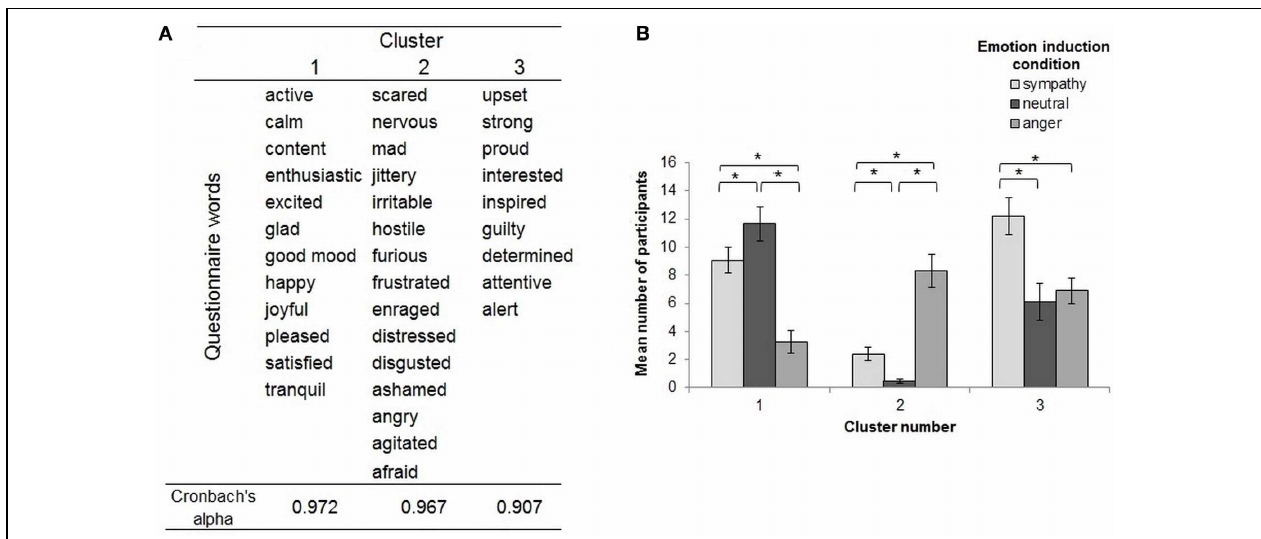
shows the average number of participants who reported experiencing those words during the sympathy, anger, and neutral emotion conditions. The asterisks highlight significant paired comparisons after Bonferroni correction ( p ≤ 0 . 017). Error bars represent ± 1